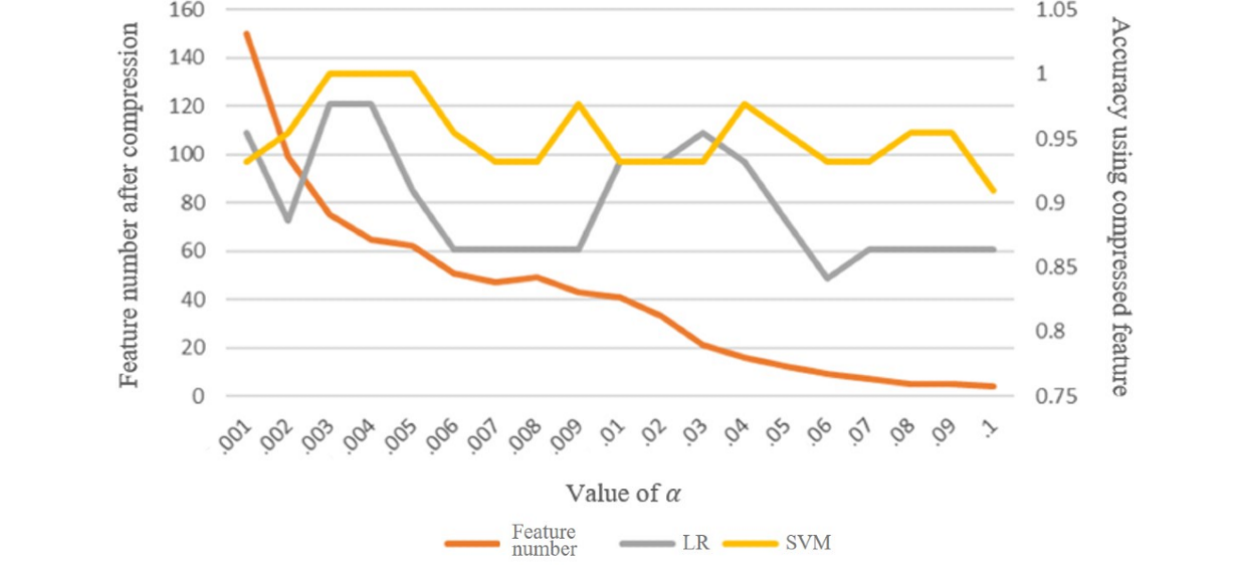
Figure 5. The effects of least absolute shrinkage and selection operator (LASSO) feature compression on logistic regression (LR) and support vector machine (SVM)